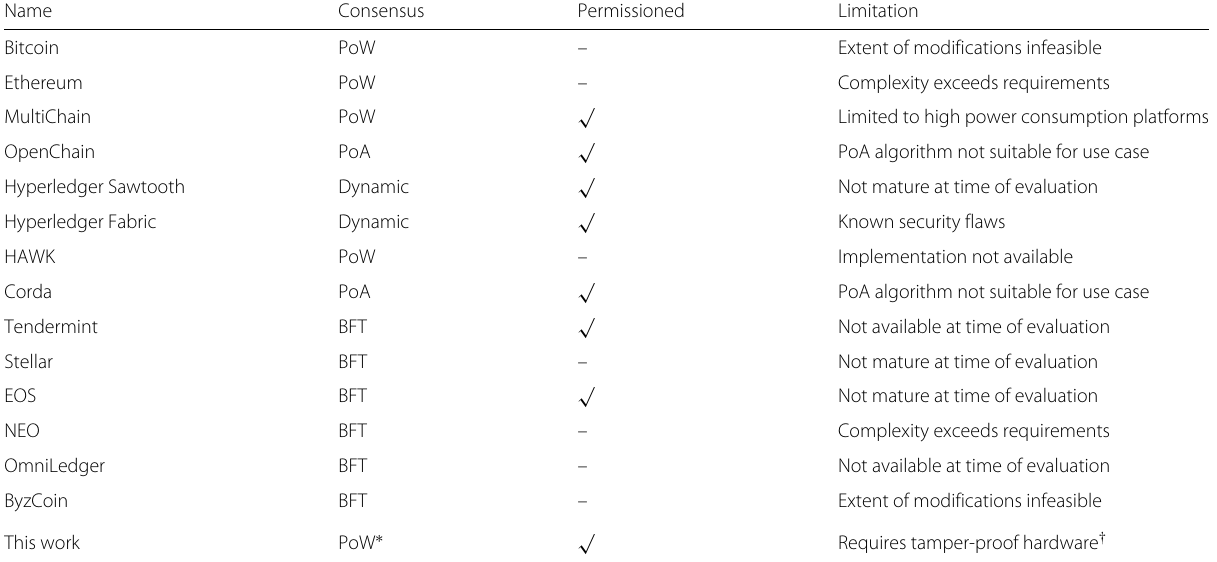
Table 1 Comparison of available implementations and their properties at the time of selecting basis implementations ( September 2017 ) and our work for